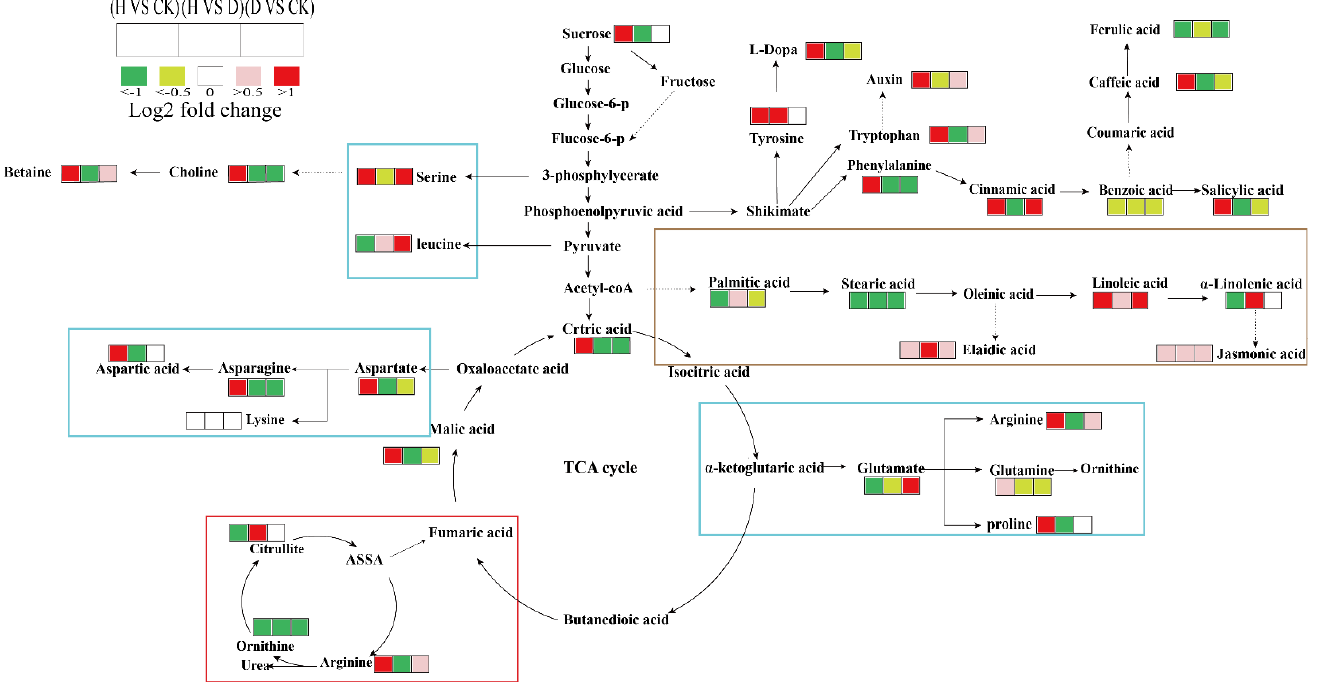
Figure 8. Schematic diagram of the proposed metabolic pathways of Fusarium wilt in Faba bean treated with H and D concentrations of P852. The fold change in the relative of primary metabolites in different groups was utilized to demonstrate the Fusarium wilt of Faba bean leaves; every chamber refers to D vs. CK, H vs. CK, H vs. D. The metabolites with red metabolites represent significant increases, and green chambers represent significant decreases ( p < 0.05).